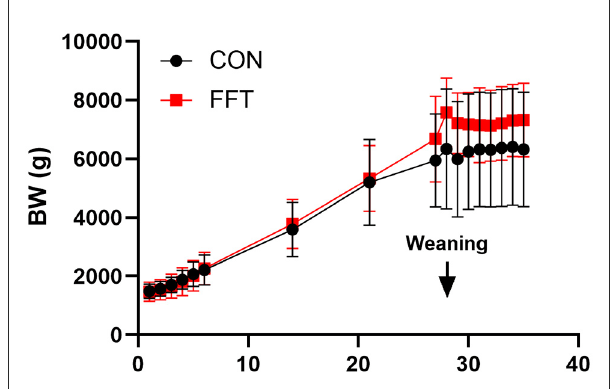
FIGURE1 Growth curve based on daily body weights of pigs from Days 1–35. The pigs received either fecal filtrate transplantation (FFT, n = 7–20) or sterile saline (CON, n = 6–18). Data are expressed as means ±